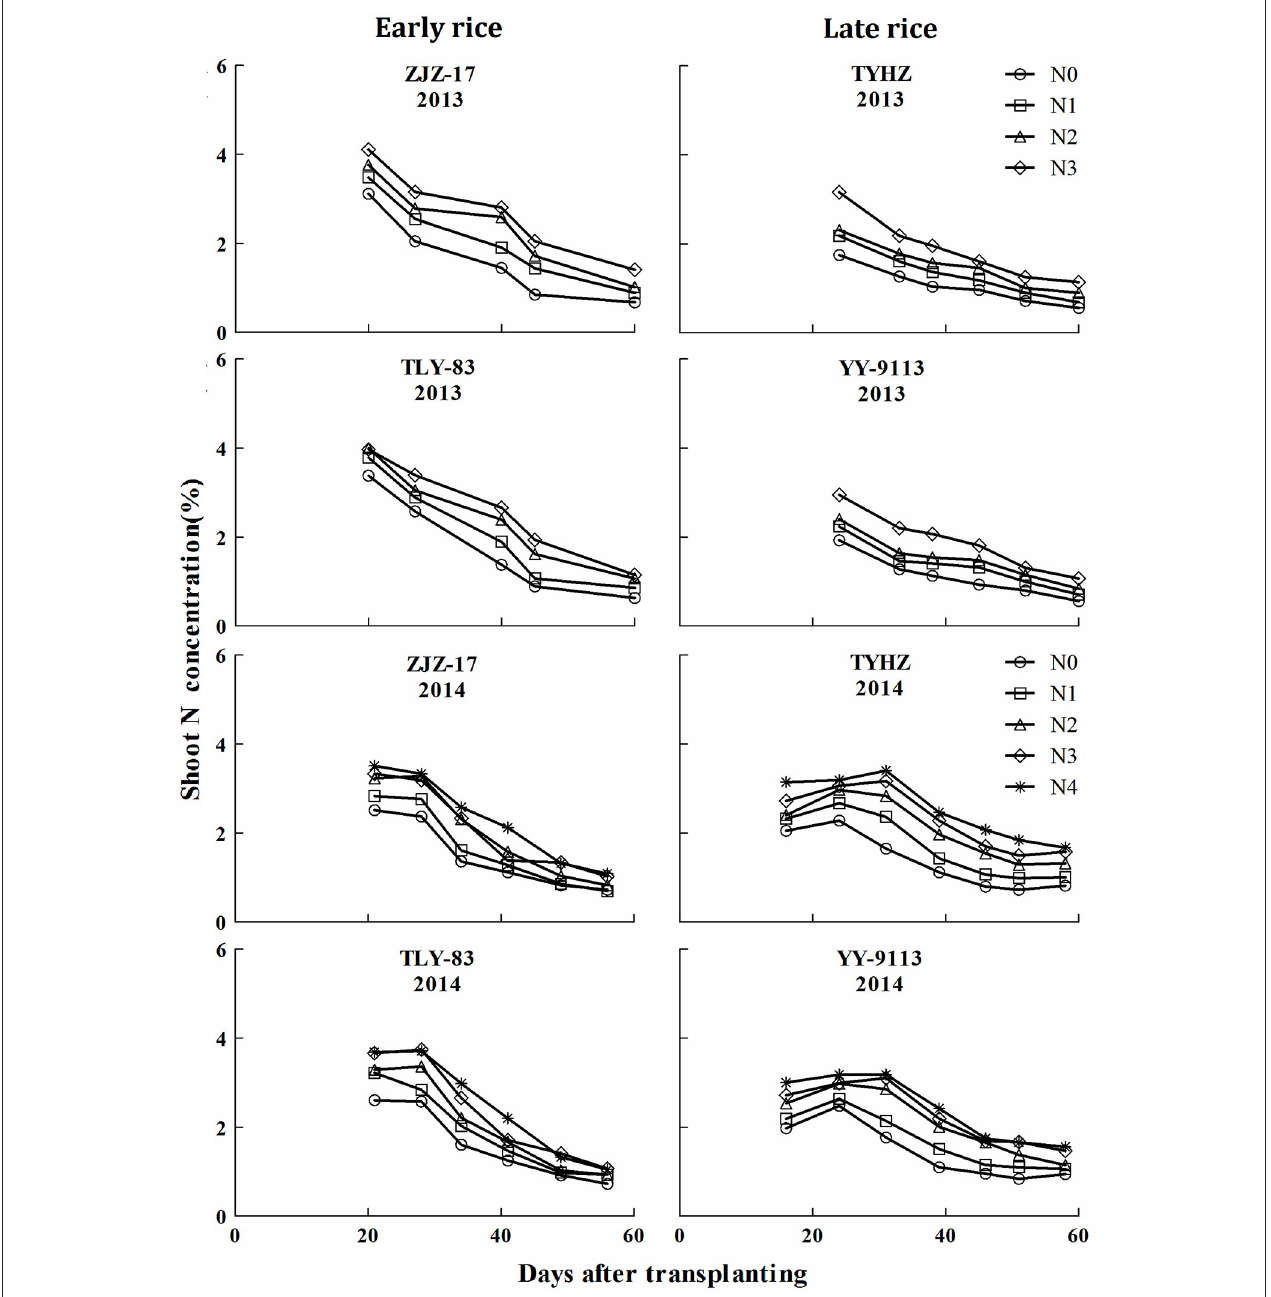
( Figure 6 ). R 2 of early and late rice models were between 0.62– 0.73 and 0.77–0.89. Slight differences were observed between the slopes and intercepts of the linear functions at different stages and between the early and late rice